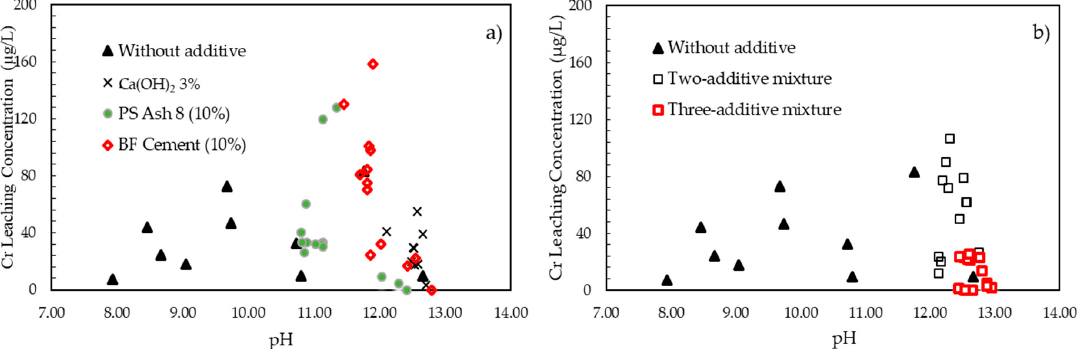
Figure 3. Effect of pH on chromium leaching concentration: a ) single additives; b ) mixed additives. Figure 3. E ff ect of pH on chromium leaching concentration: ( a ) single additives; ( b ) mixed